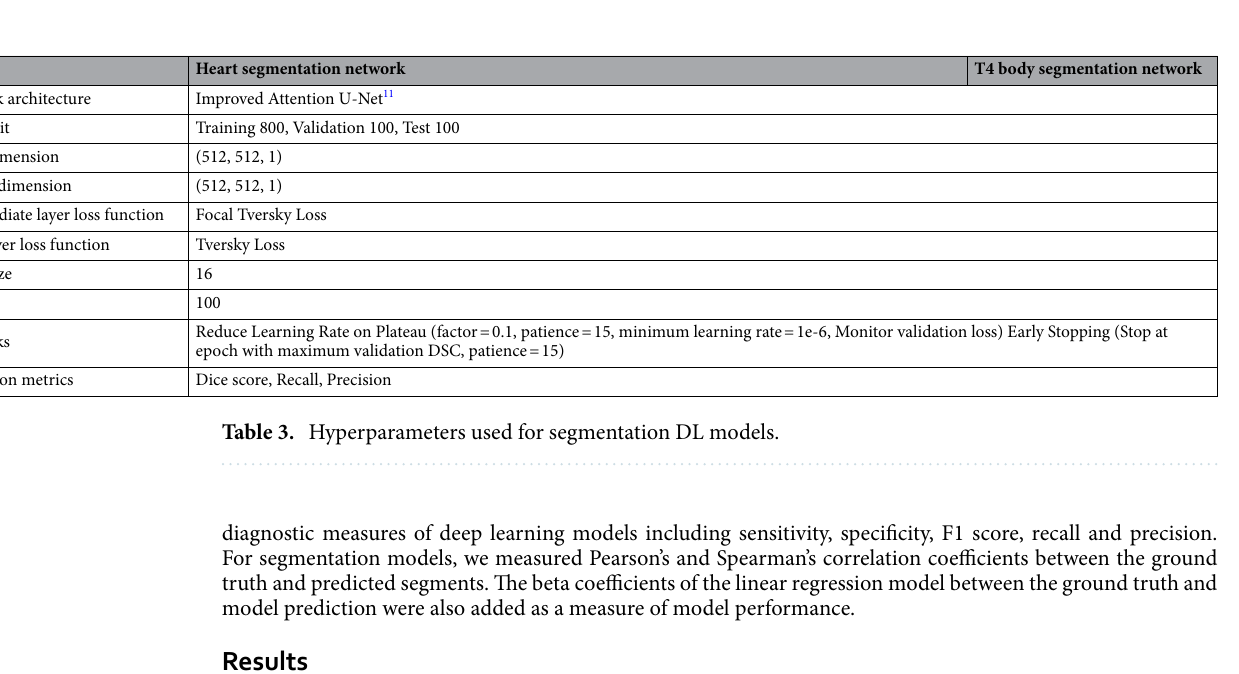
Table 2. Hyperparameters used for segmentation DL models.